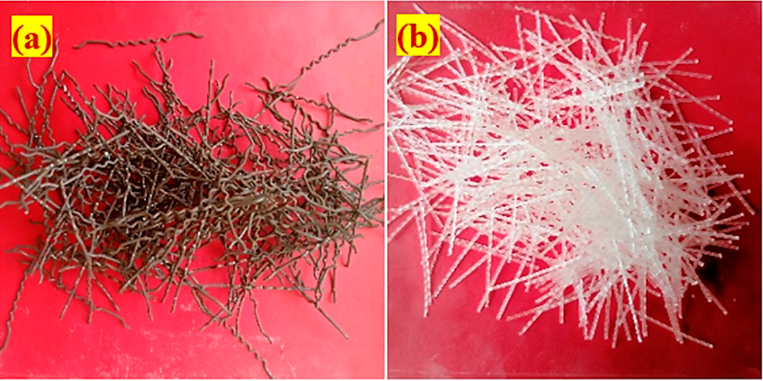
Figure 3. Fibre appearance ( a ) Steel fibre and ( b ) Polypropylene fibre. Table 1. Mixing composition of the composite.